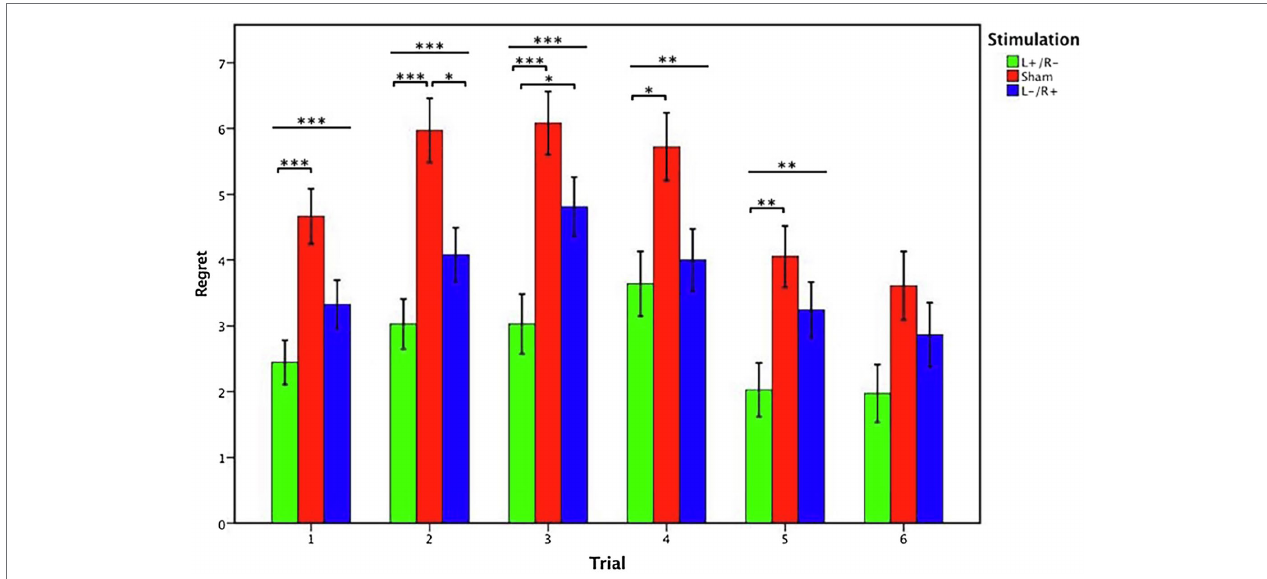
FIGURE 4 | Data of regret ratings in the gambling tasks. The mean regret ratings across three stimulations from trial 1 to trial 6. Error bars represent standard error. Asterisks indicates statistically significant difference between the stimulation types.